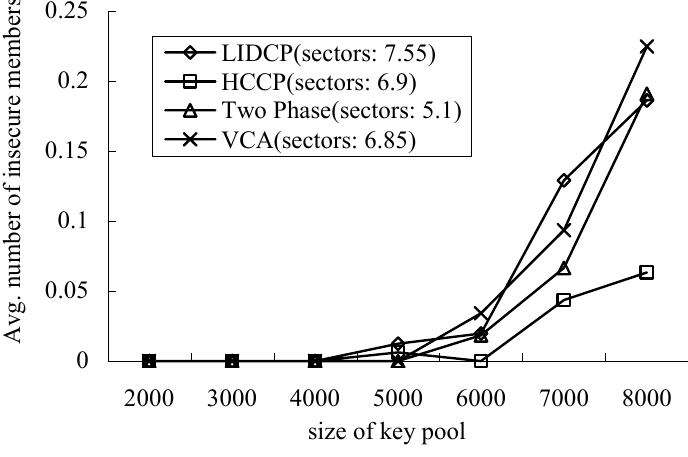
Figure 2. Insecure members vs. size of key pool.